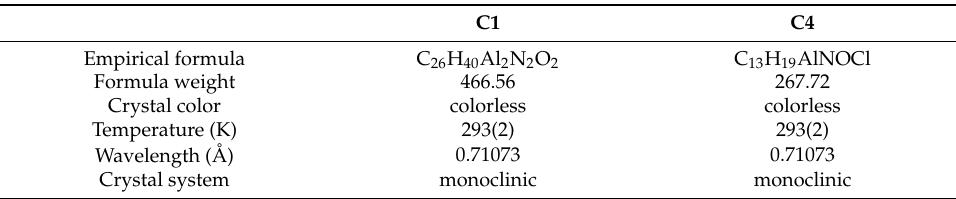
Table 1. Crystal data and structure refinement for C1 and